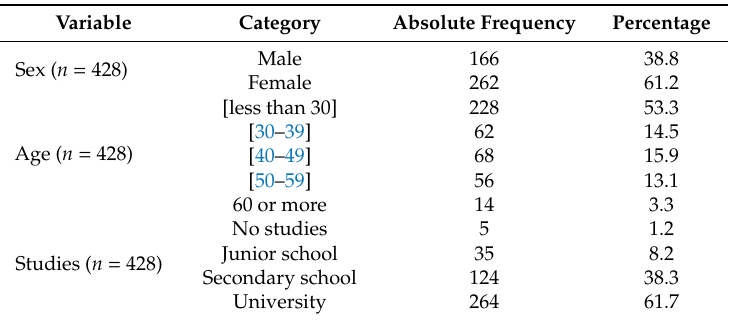
Table 2. Sociodemographic profile of visitors.